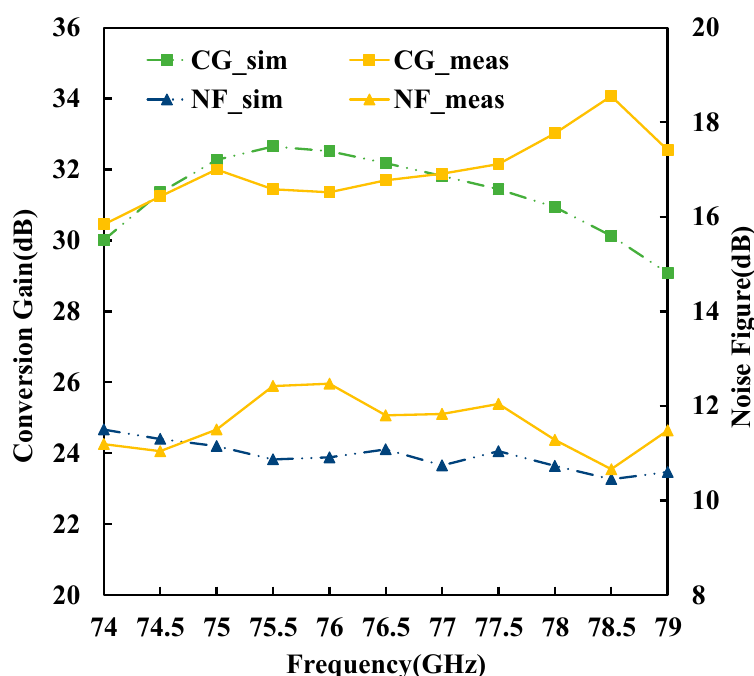
Figure 17. The conversion gain and NF measurement results.